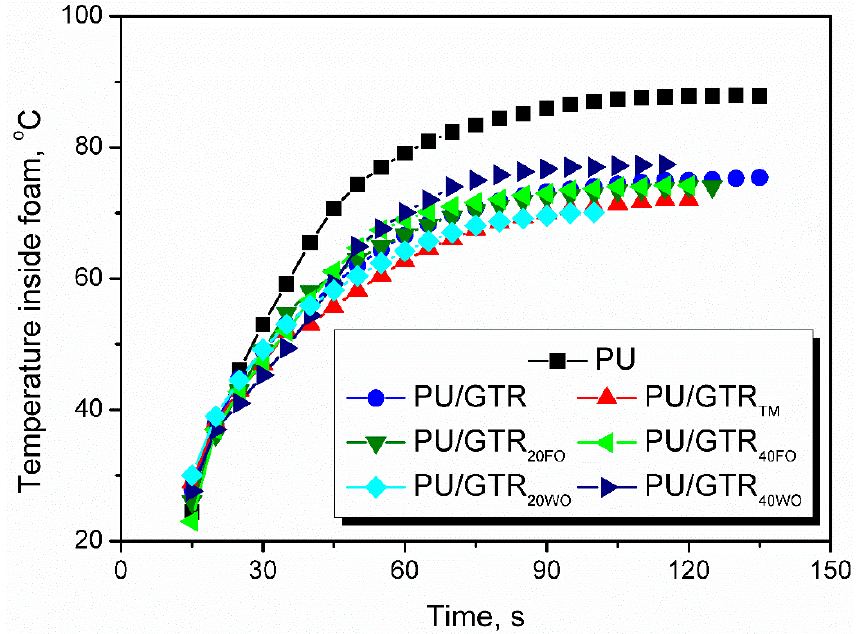
Figure 2. The impact of formulation on the temperature inside foam during polymerization.